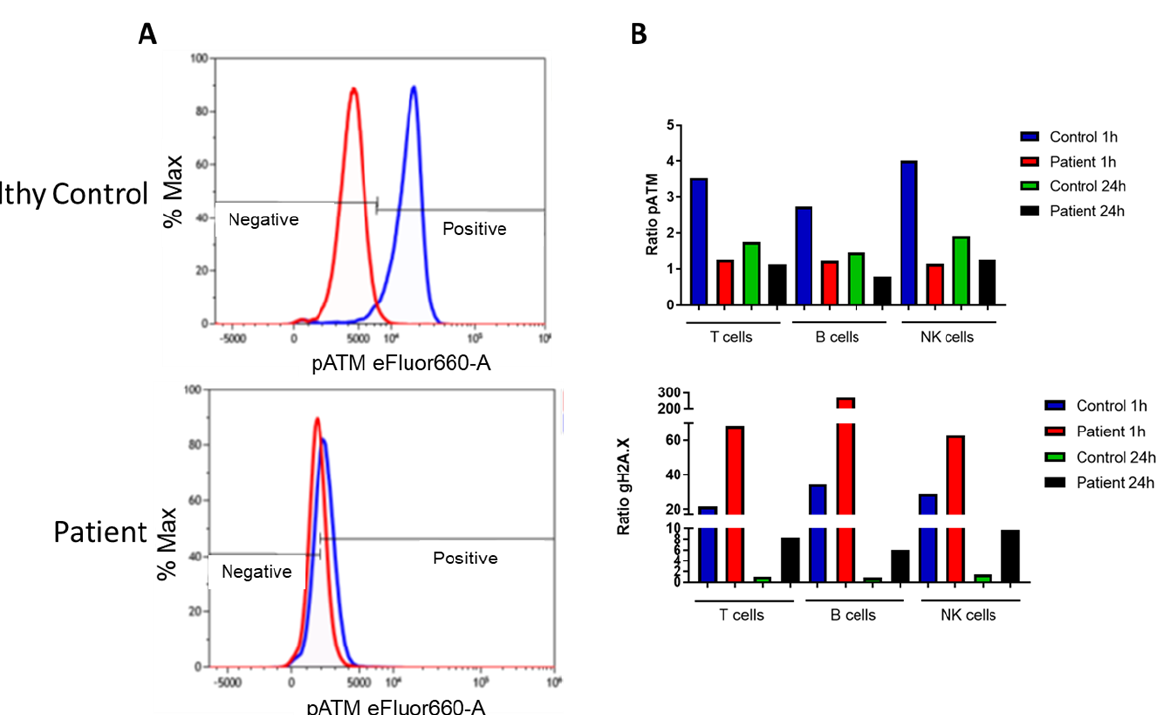
Figure 4. Case 2, Analysis of pATM and gamma H2AX. ( A ) Analysis of pATM in CD3 + T cells in healthy control and patient T cells. Red histograms represent non-irradiated cells; blue histograms represent cells exposed to low dose (2 Gy) radiation. The phosphorylated proteins were assessed at 1 h and 24 h post-irradiation. (similar data was obtained for patient B and NK cells (data shown in bar graph, ( B )). ( B ) The median mean fluorescence intensity (MFI) was plotted as a ratio of irradiated to unirradiated data for pATM (top graph) and gamma H2AX (bottom graph). The patient (red bars) shows almost absent (close to a ratio of 1) ATM phosphorylation compared to an experimental healthy control (blue bar) at 1 h post-2Gy irradiation. At 24 h post-irradiation, the control (green bar) shows normal DNA repair and dephosphorylation of pATM, while the patient (black bar) shows no change from the 1 h time point for T, B, and NK cells. In the lower graph, the median MFI ratio for gamma H2AX is depicted, which shows significantly higher expression in the patient (red bar) compared to control (blue bar) at 1 h post-irradiation, suggesting increased foci of DNA DSB. At 24 h post-irradiation, the patient (black bar) shows persistence of gamma H2AX compared to the control (green bar), indicating defective DNA repair.